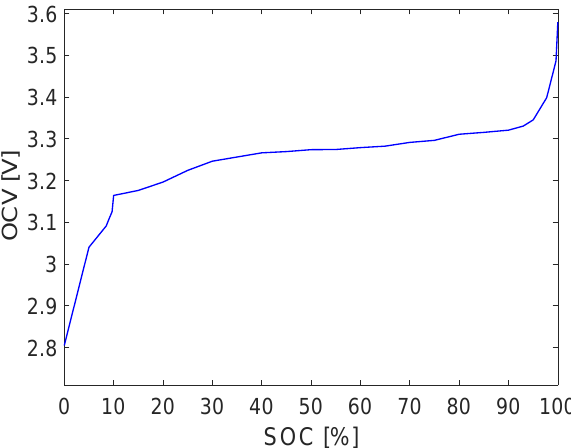
Figure 2. Open circuit voltage (OCV) versus state-of-charge (SOC) of the battery [26].